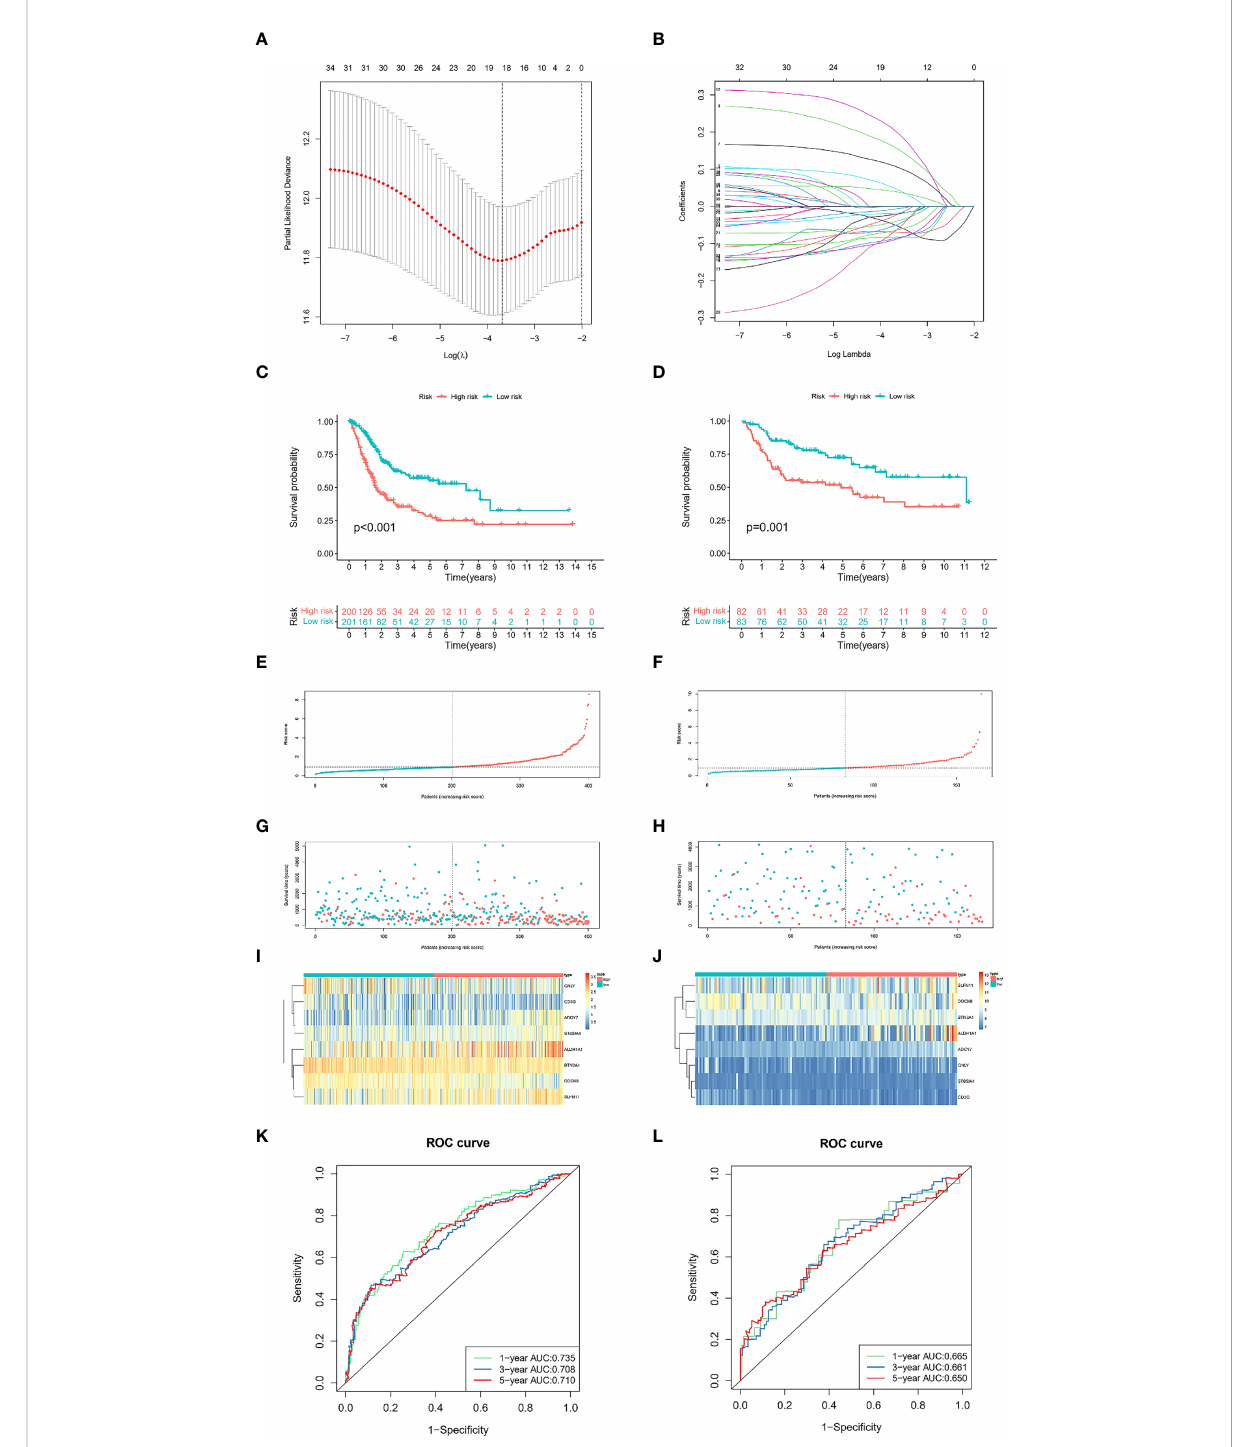
FIGURE 2 Development and validation of the TILS. The minimum standard (A) and the corresponding coef fi cient (B) of LASSO Cox regression analysis. Kaplan-Meier survival curves of high- and low-risk groups in the TCGA-BLCA (C) and GSE13507 dataset (D) . Red represents high risk, and cyan represents low risk. The distribution of risk score and survival status of BCa patients with increasing risk score in the TCGA-BLCA dataset (E, G) and GSE13507 dataset (F, H) . Heatmap for the expression of eight crucial genes in low- and high-risk groups in the TCGA-BLCA (I) and GSE13507 dataset (J) . ROC curves analysis of TILS on OS at 1-year, 3-years, and 5-years in the TCGA-BLCA (K) and GSE13507 dataset (L)